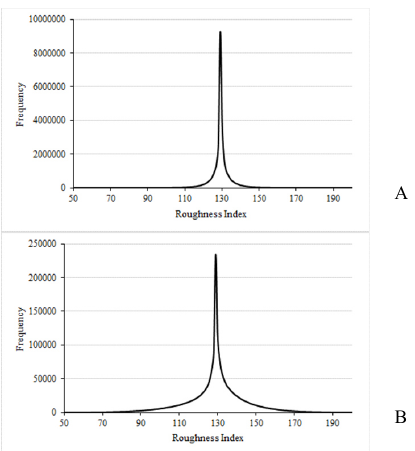
Figure 8 . Histograms. A. DEM 5 meters moving window 3×3; B. DEM 20 meters moving window 5×5.